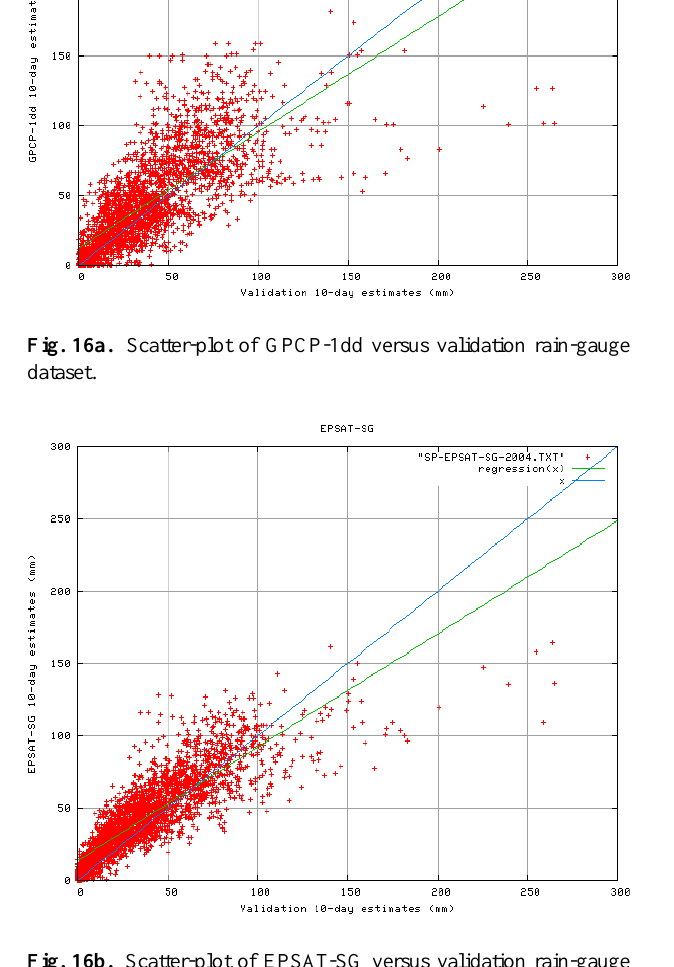
Figure 16.b. Scatter-plot of EPSAT-SG versus validation rain-gauge dataset. Fig. 16b. Scatter-plot of EPSAT-SG versus validation rain-gauge dataset.